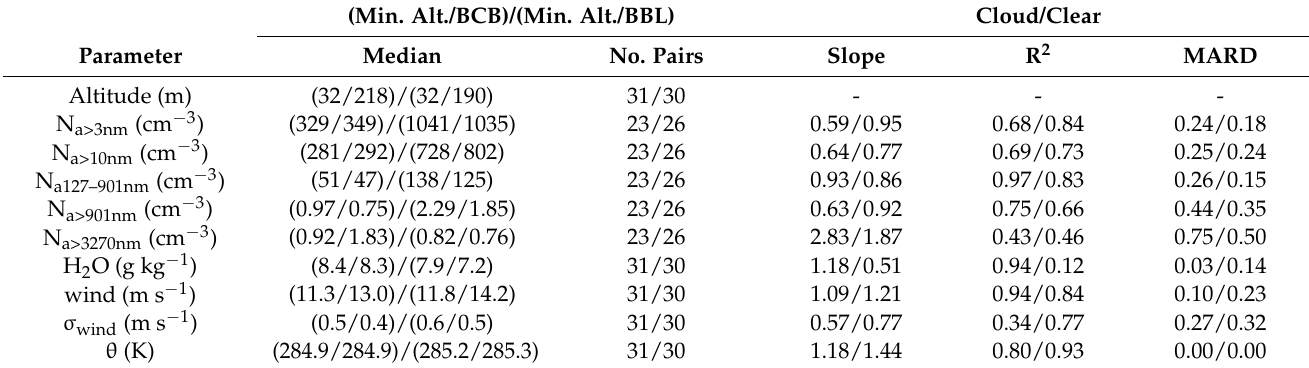
Table 2. Statistics for selected aerosol, gaseous, and meteorological variables measured during MONARC 2019 flights. Statistics are calculated for Min. Alt./BCB legs and Min. Alt./BBL legs for cloud and clear ensembles, respectively, in the first two data columns (additional statistics for 25th/75th percentiles and minimum/maximum values are in Table S1). The rightmost three columns report correlation statistics between different leg pairs conducted at different heights within the MBL for cloud (i.e., Min. Alt. and BCB) and clear (i.e., Min. Alt. and BBL) ensembles during MONARC 2019